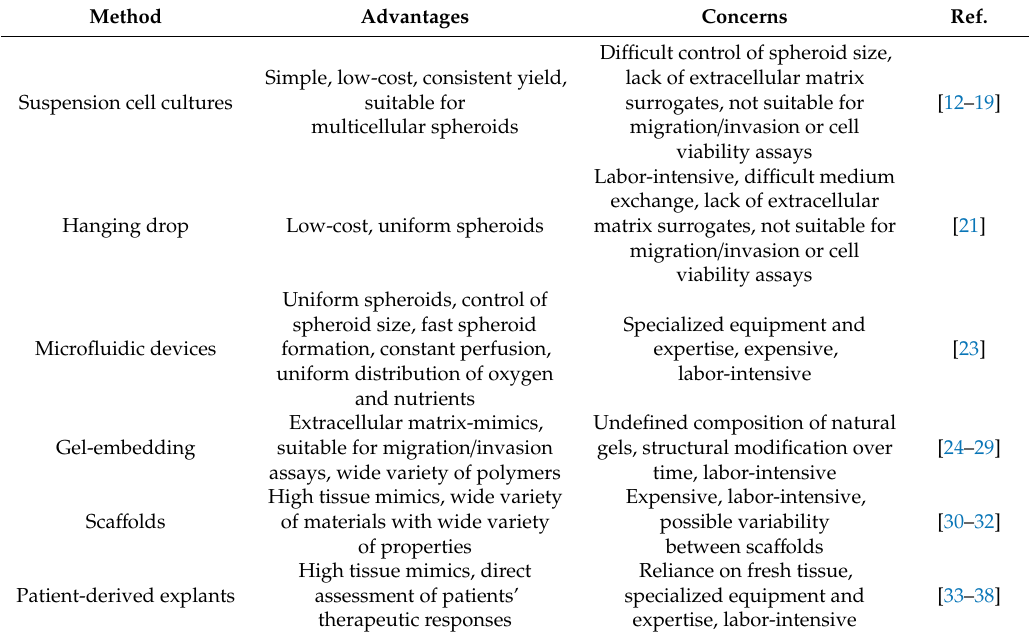
Table 1. Methods of 3D prostate cancer (PCa) cell